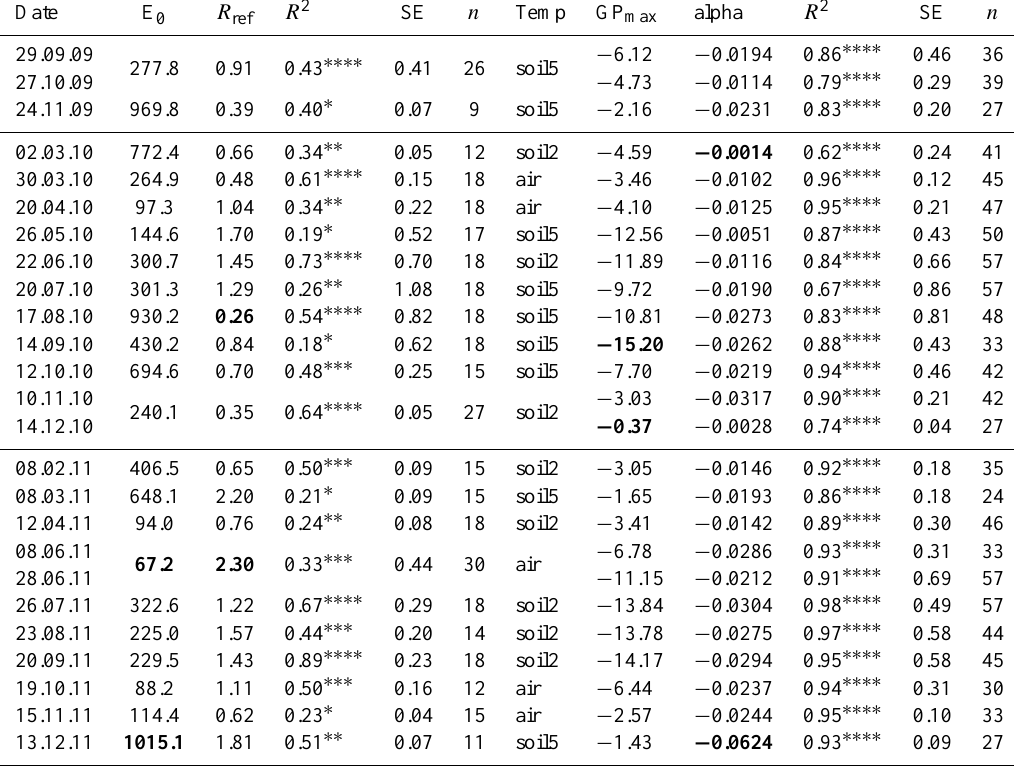
Table 6. Parameters for the R eco and NEE models of “ Sphagnum cultivation”; E 0 : activation energy such as parameter [K]; R ref : respiration at the reference temperature [µmolCO 2 -Cm − 2 s − 1 ]; temp: best fit temperature for R eco model. GP max : maximum rate of carbon fixation at tion (Pearson) between modelled and measured values. SE: standard error of the model [µmolCO 2 -Cm − 2 s − 1 ]; n : number of samples. Max. and min. values are printed in bold. Eventually measurement campaigns were pooled